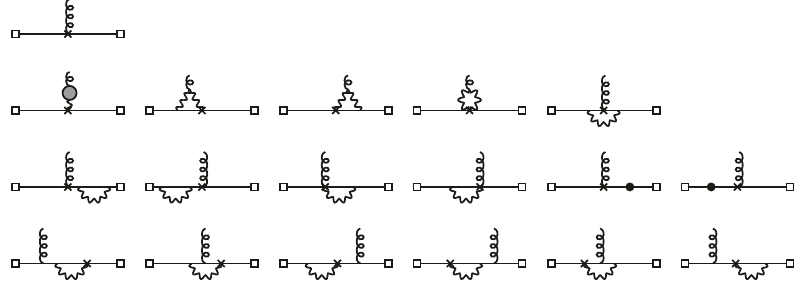
Figure 3 . The LO and NLO graphs contributing to the 3-point correlator in the IR description of section 6. The notation is the same as in figure